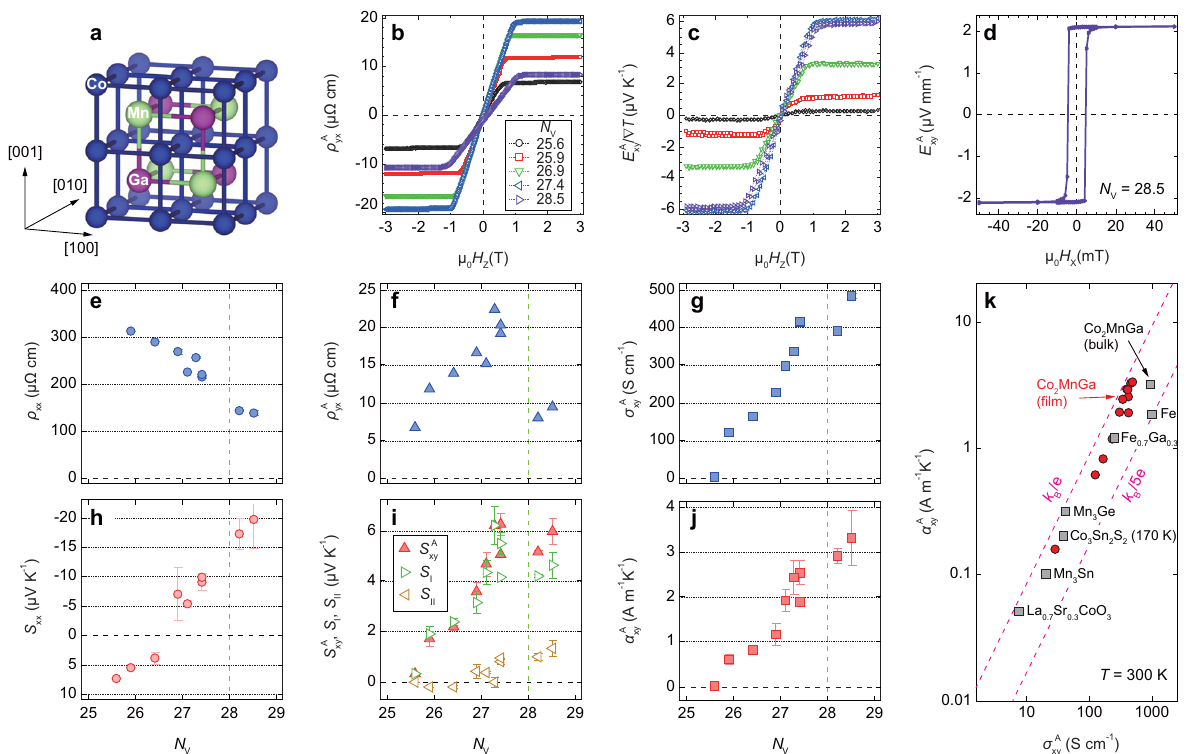
Fig. 1 Anomalous transport properties of L 2 1 -ordered Co 2 MnGa fi lms. a Schematic of the L 2 1 -ordered structure of Co 2 MnGa. Dependence on perpendicular external magnetic fi eld ( H z ) of b ρ A yx and c E A xy normalized by given temperature gradient ∇ T x in the Co 2 MnGa fi lms. d E A xy measured by giving the perpendicular temperature gradient ∇ T z and sweeping the in-plane magnetic fi eld H x for the sample with N v = 28.5. Dependence on total valence electron number N v of e ρ xx , f ρ A yx , g σ A xy , h S xx , i S A xy , S I and S II and j α A xy . Green dashed lines in e – j indicate N v for the stoichiometric composition. All error bars represent standard deviation. k Relationship between α A xy vs. σ A xy in our Co 2 MnGa fi lms (red circles) and different magnets (gray squares: taken from ref. 34 ).